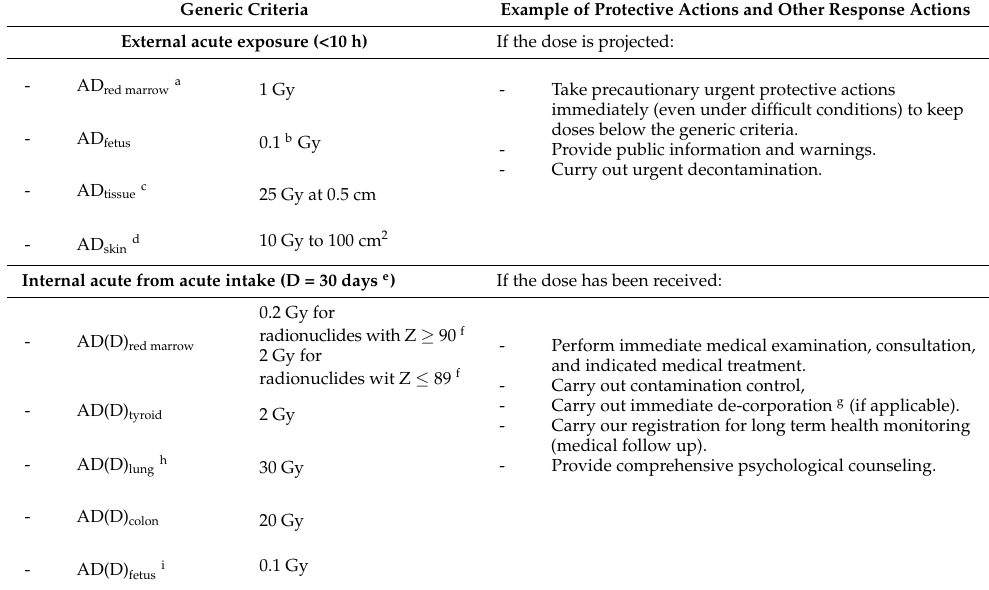
Table 4. Tissue effects absorbed (projected or received) dose levels that require immediate protective actions, from IAEA [17]—see Appendix D for a,b,c,d,e,f,g,h,i’s